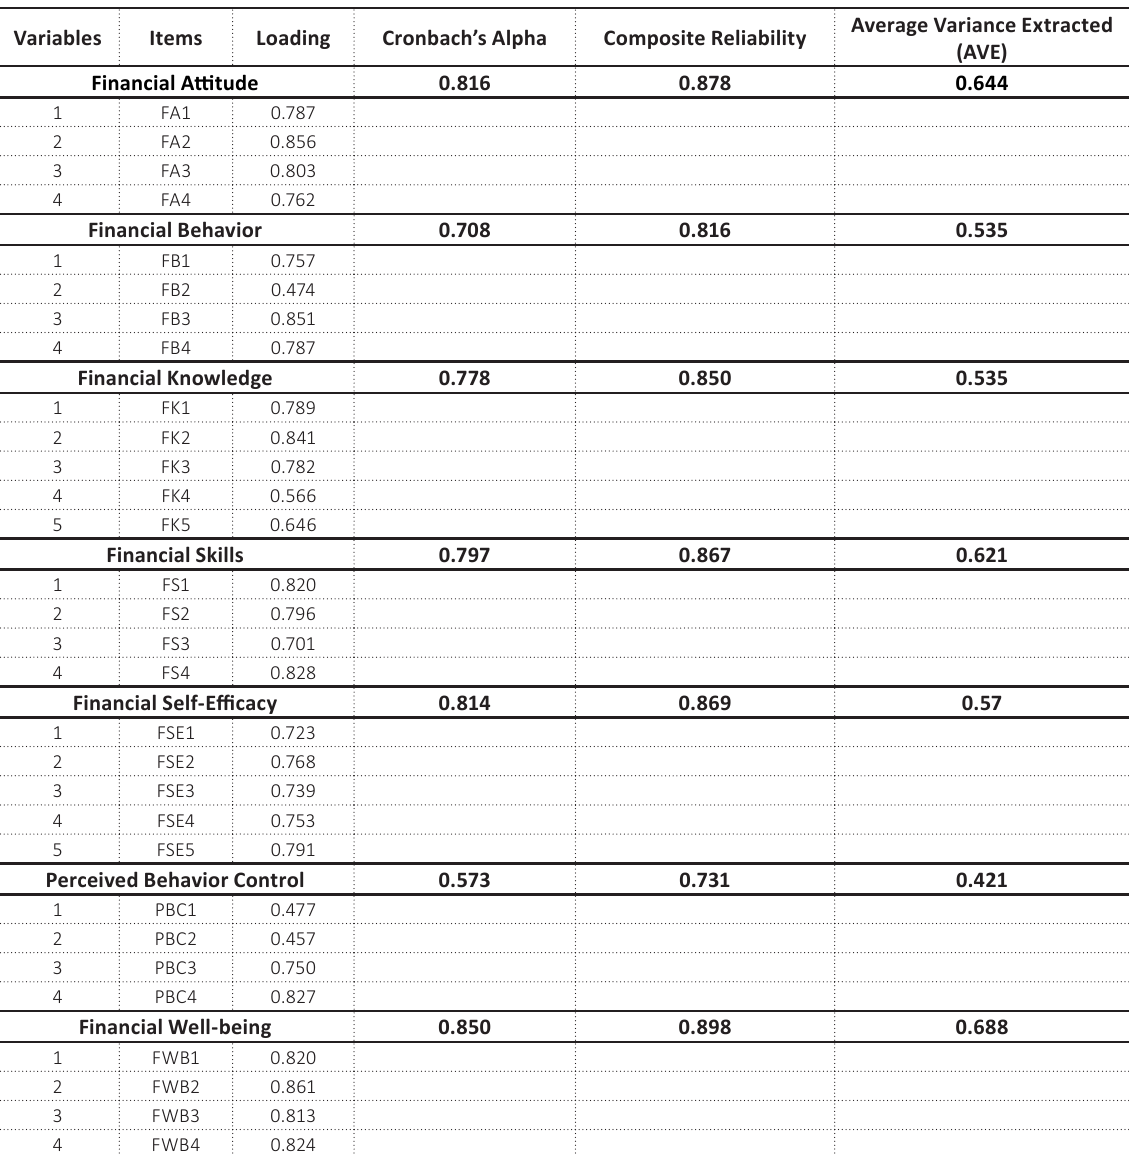
Table 3. The result of PLS-SEM algorithm analysis Variables